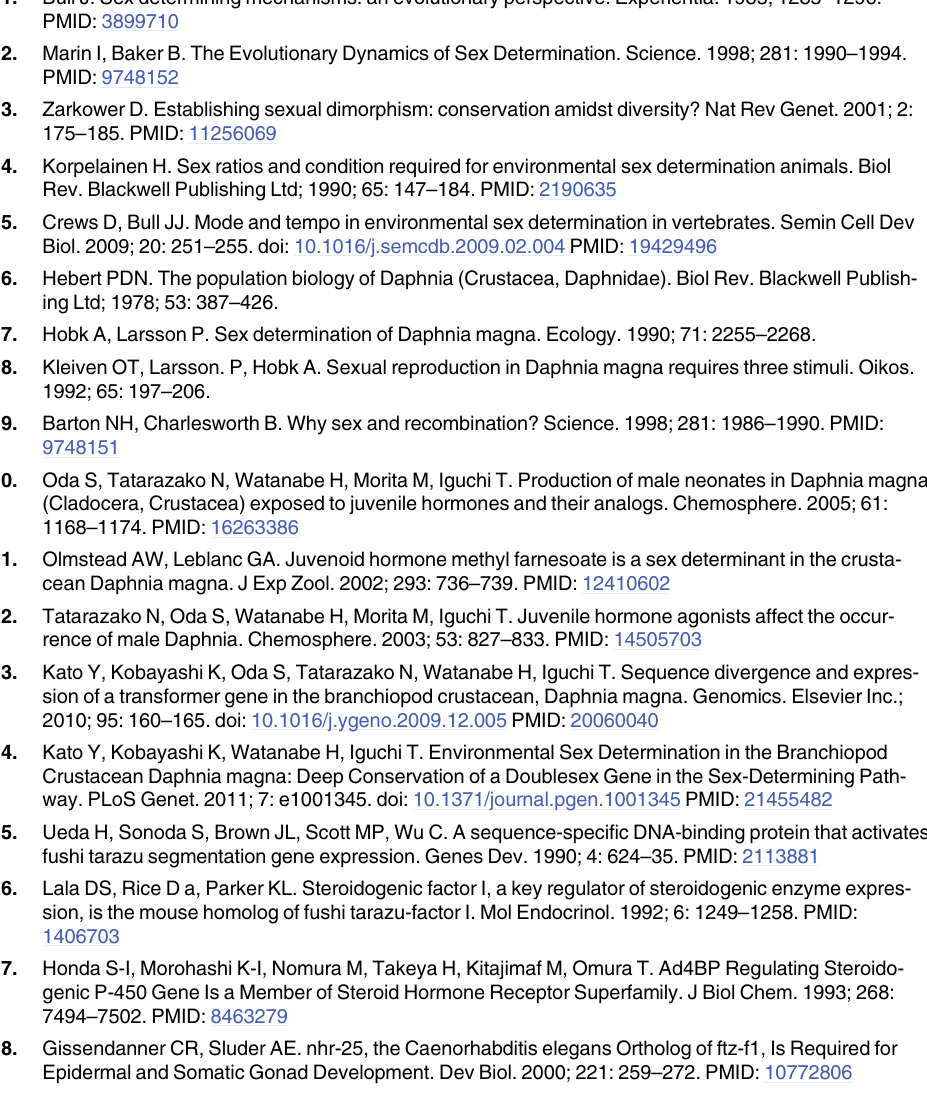
S1 Table. The number of embryos and amount of isolated total RNA from each males and females